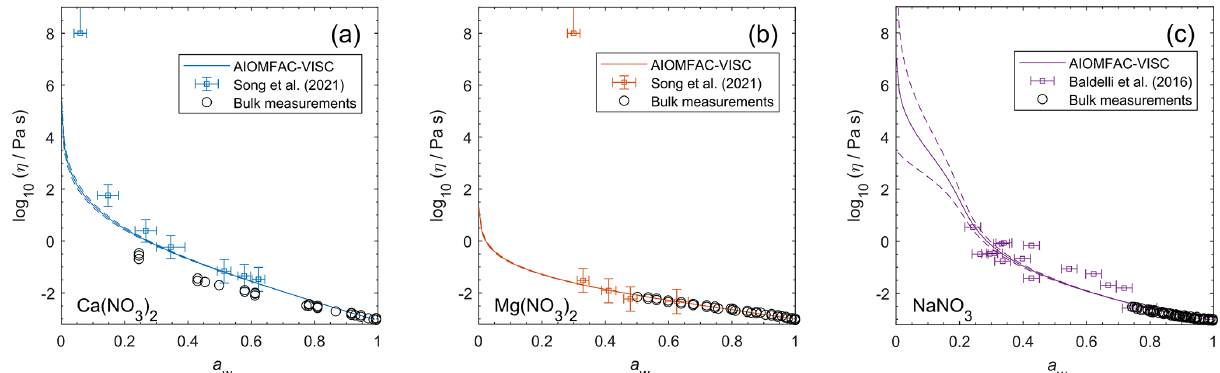
Figure 9. Viscosity predictions for aerosol surrogate mixtures containing nitrate salts at varying water activity, a w (RH). Model sensitivity, defined by a ± 2% change in aerosol water content, is shown in dashed curves. Bulk measurements (see Table 2) were collected at defined concentrations and converted to a w using AIOMFAC; the points collected at temperatures between 295 ± 5K are shown. Song et al. (2021) used poke-and-flow and bead mobility techniques. Baldelli et al. (2016) used holographic optical tweezers.